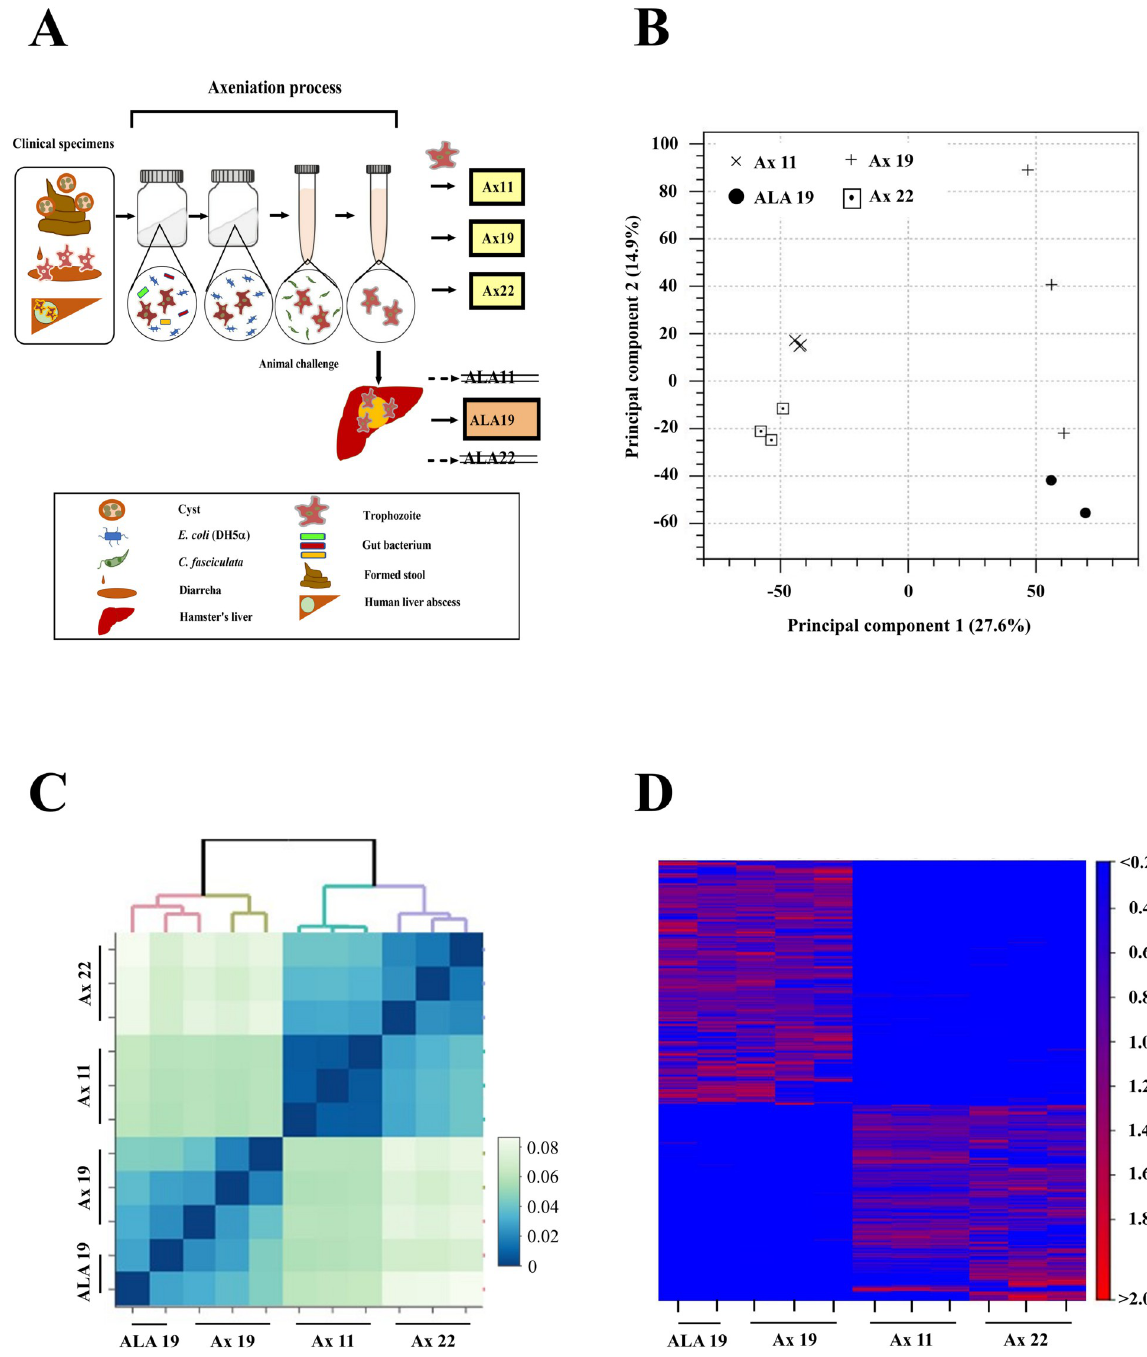
Fig 2. Transcriptome profiling of RNA-seq reads in the isolated clinical strains. (A) Workflow for the RNA-seq experimental procedure. The E . histolytica clinical strains were isolated from each clinical specimen. First, they were incubated under xenic conditions with E . coli and rice starch in Robinson’s medium for several weeks to reduce human gut bacteria gradually. After adaptation to the xenic culture, the parasites were next transferred to monoxenic culture medium with Crithidia fasciculata . Finally, the parasites were maintained in axenic culture without any bacteria. Animal experiments involved injecting axenically-cultured clinical strains to assess the parasite’s virulence in terms of liver abscess formation. Liver abscesses were successfully formed only when Ax19 (liver abscess strain) was injected. Total RNA was extracted from the trophozoites of the in vitro -cultured strains (Ax11, Ax19, and Ax22) and the animal-passaged strain (ALA19). (B) Two-dimensional (2D) plot showing principal components analysis (PCA) of the RNA-seq reads. Each data point represents a read, with the three isolated clinical strains being analyzed in triplicate. The expression pattern of the Ax19 strain is distinct from those of other two strains. (C) Hierarchical clustering